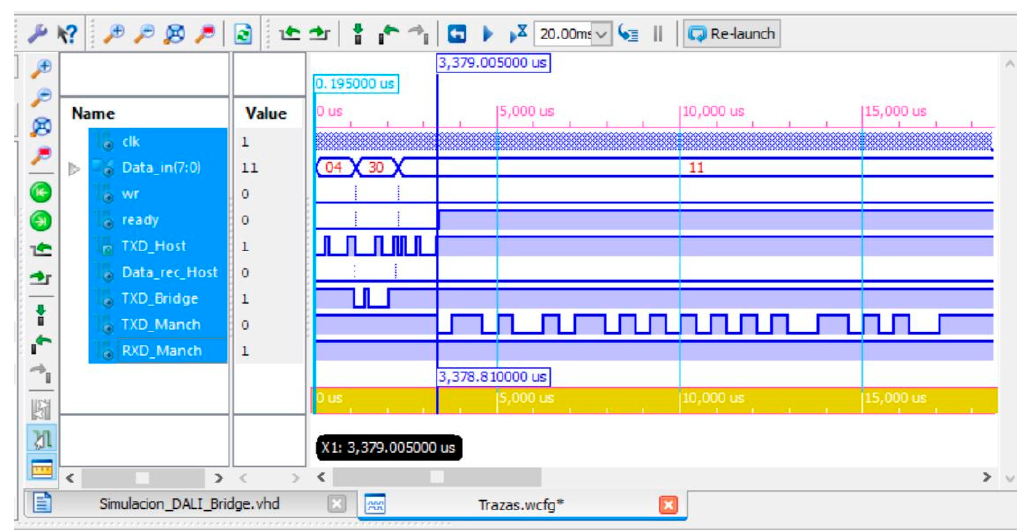
Figure 22. DALI Bridge response time including communication time.